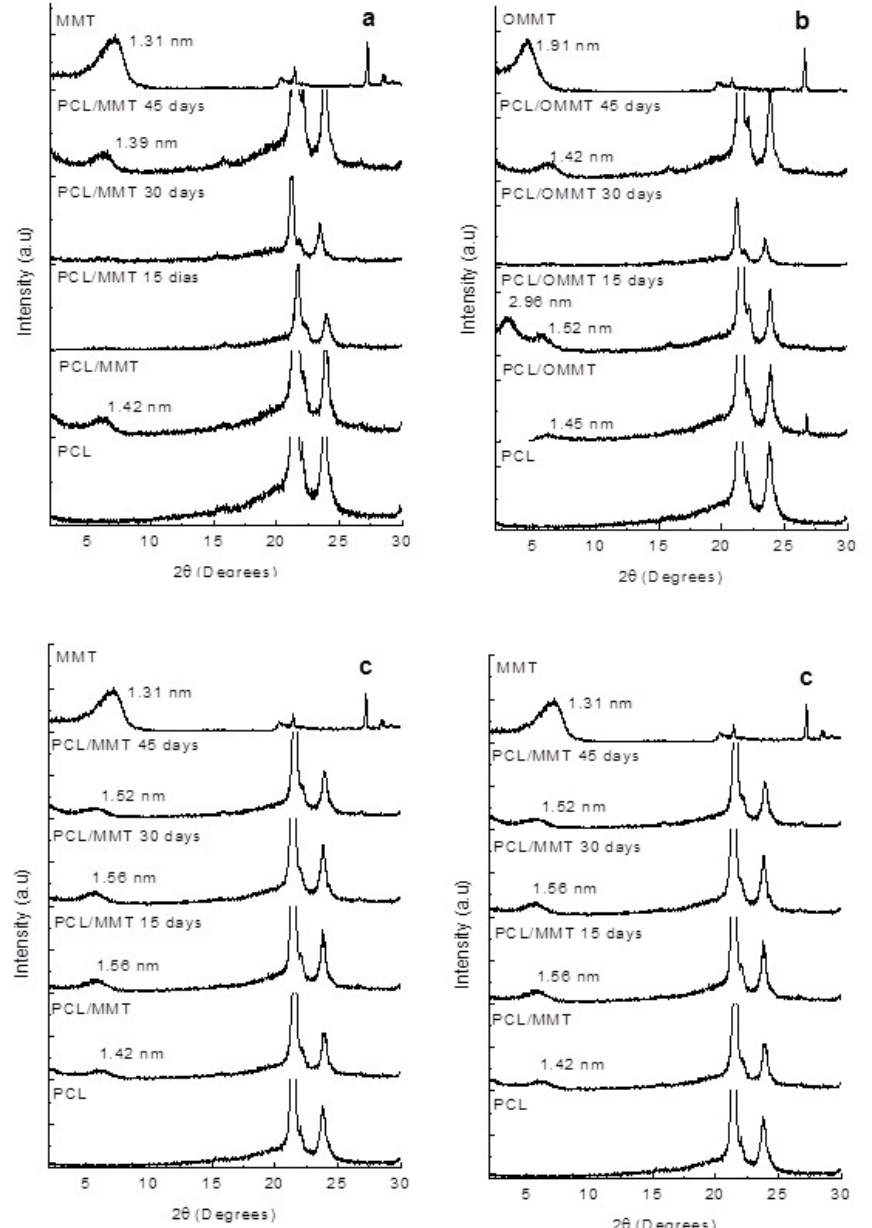
Figure 8. X ray diffratograms of MMT, OMMT, PCL, PCL/MMT and PCL/OMMT compounds. (a) and (b) tests executed with specimens subjected to vacuum at 40oC, (c) and (d) specimens immersed in aqueous medium at 40oC. Degradation time